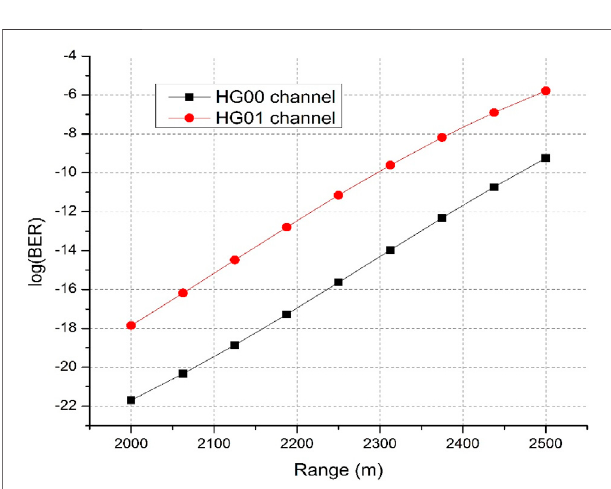
FIGURE 5 | log (BER) v/s transmission distance for very light dust. ( V ≤ 10 km ).